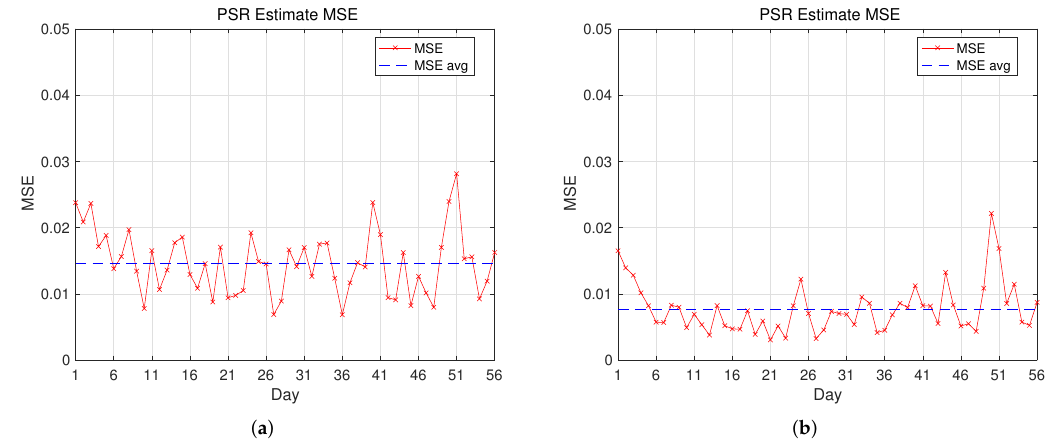
Figure 12. MSE comparison in PSR estimate for Daejeon TS. ( a ) Conventional approach: estimate designed excluding the link BPS features (MSE average: 0.0146). ( b ) Proposed approach: estimate designed using the 20 BPS features as Figure 10 (MSE average: 0.0077).